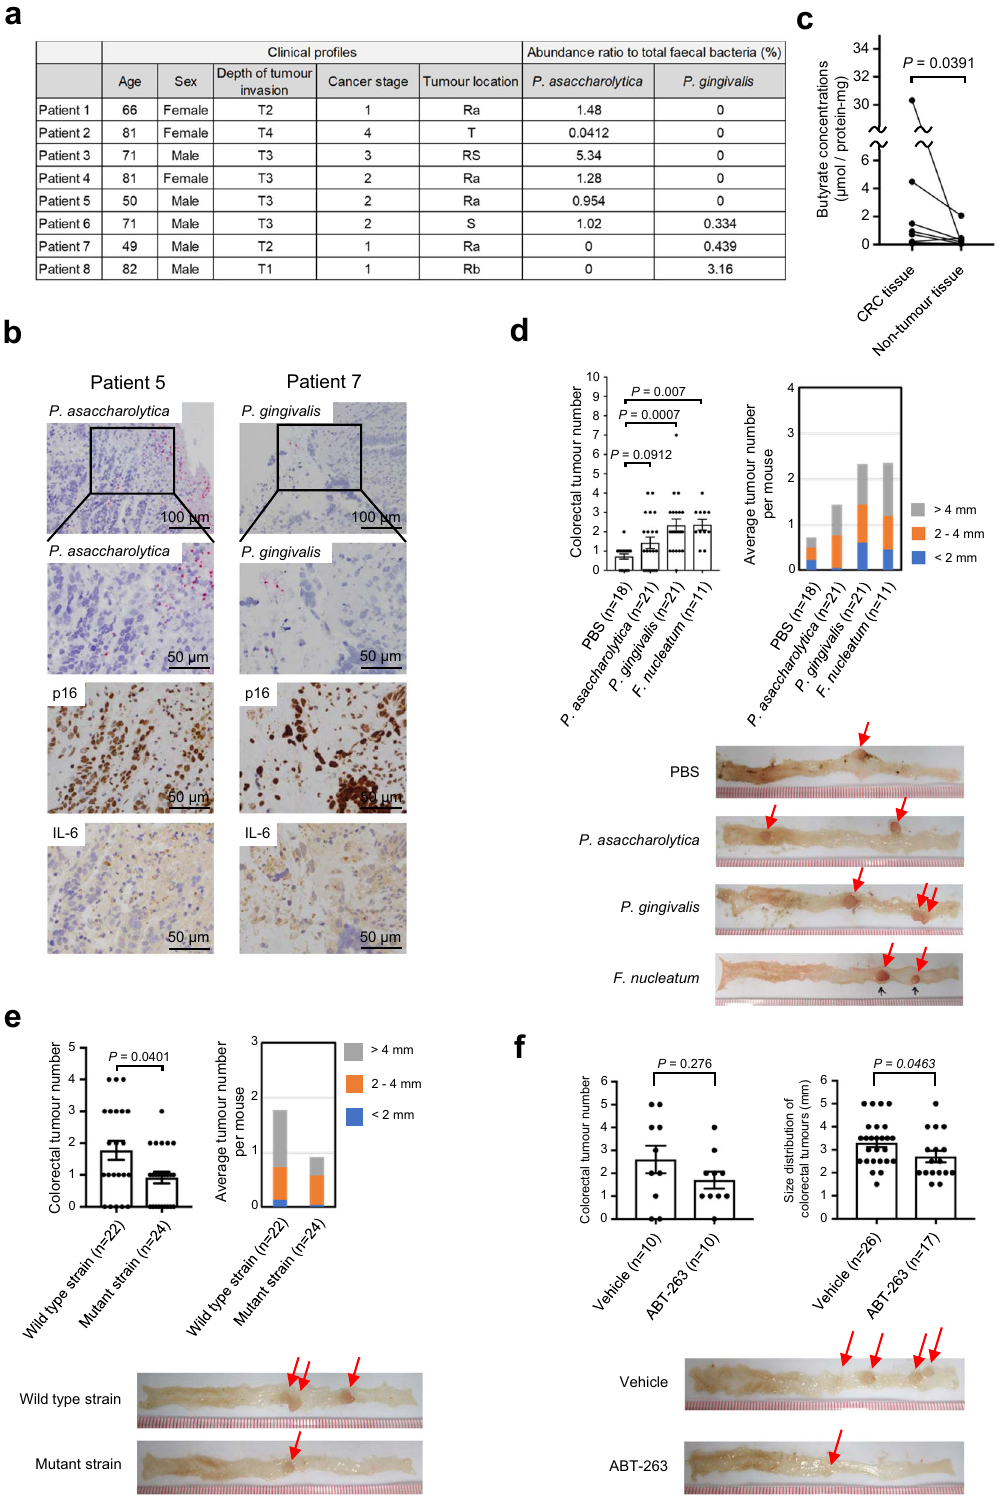
clinical samples was approved by the Ethics Committee of the JFCR and Osaka University and all participants provided written informed consent. In situ hybridization . Chromogenic RNA in situ hybridization targeting to speci fi c bacterial species ( P. asaccharolytica and P. gingivalis ) in colorectal cancer tissues was performed using RNAscope ® 2.5 HD Reagent Kit- RED (Advanced